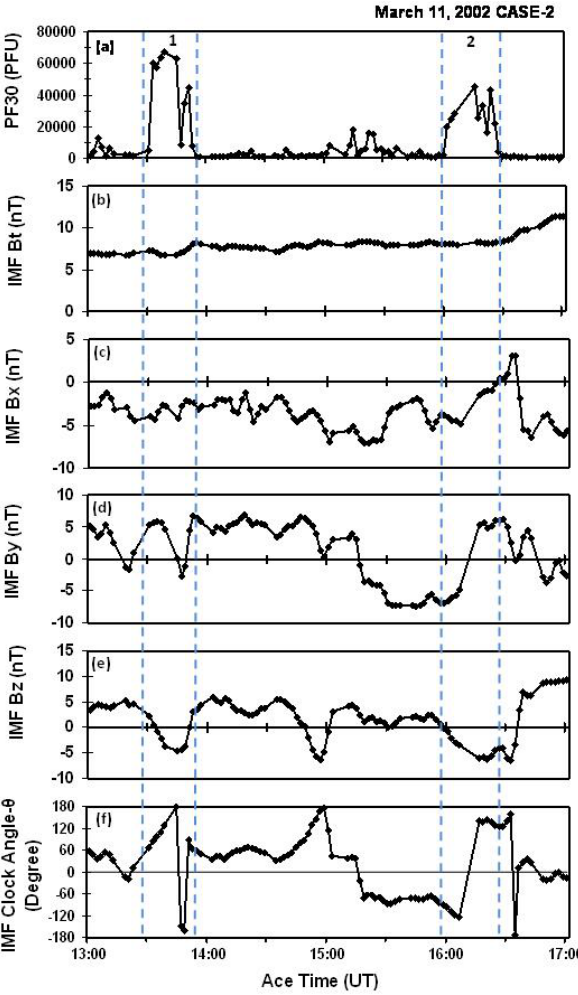
Fig. 13a. ACE magnetic field data for Case 2, 11 March 2002. From top to bottom PF30, IMF strength, IMF B x , IMF B y , IMF B z , and IMF clock angle versus time. PF30 was added to guide the features in Cluster data. Cluster data were shifted to the ACE times concurrently to account for the solar wind convection time